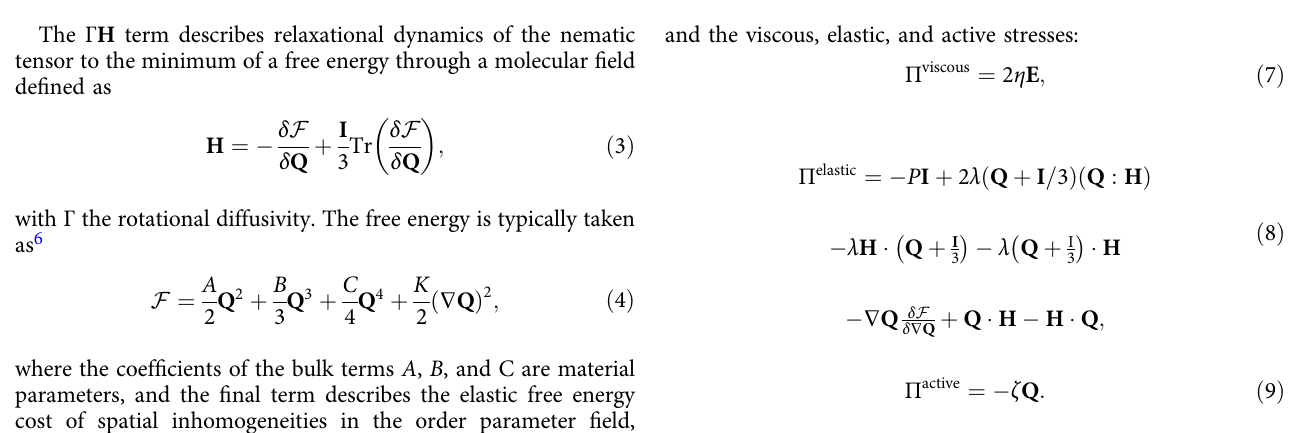
Fig. 1 Active nematic turbulence. a Fluorescence confocal microscopy micrograph of the active nematic in contact with an oil of 0.05 Pa s (see Supplementary Movie 1 where positive defects are tracked). b Snapshot of the time evolution from solving the continuum equations of motion, showing active turbulence. A comet-like, + 1/2, and a trefoil-like, − 1/2 defect are highlighted in each case. c Particle alignment and velocity fi elds around ±1/2 topological defects in extensile and contractile active systems. d Experimental distribution of vortex sizes in an active nematic in the regime of active turbulence, adapted from data in ref. 15 , Nature Publishing Group. The solid line is an exponential fi t to the